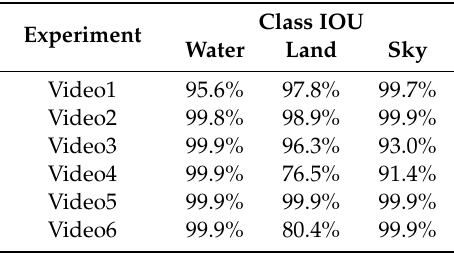
Table 2. Performance in new environments.